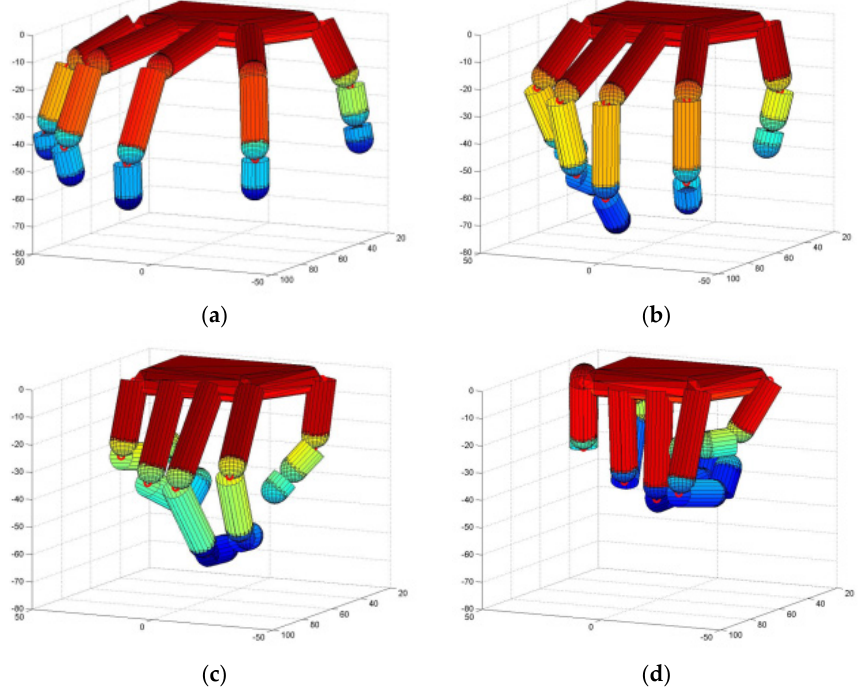
Figure 9. Manipulator grasping based on gesture cooperation. ( a ) Simulation step 1; ( b ) Simulation step 35; ( c ) Simulation step 70; ( d ) Simulation step 100.